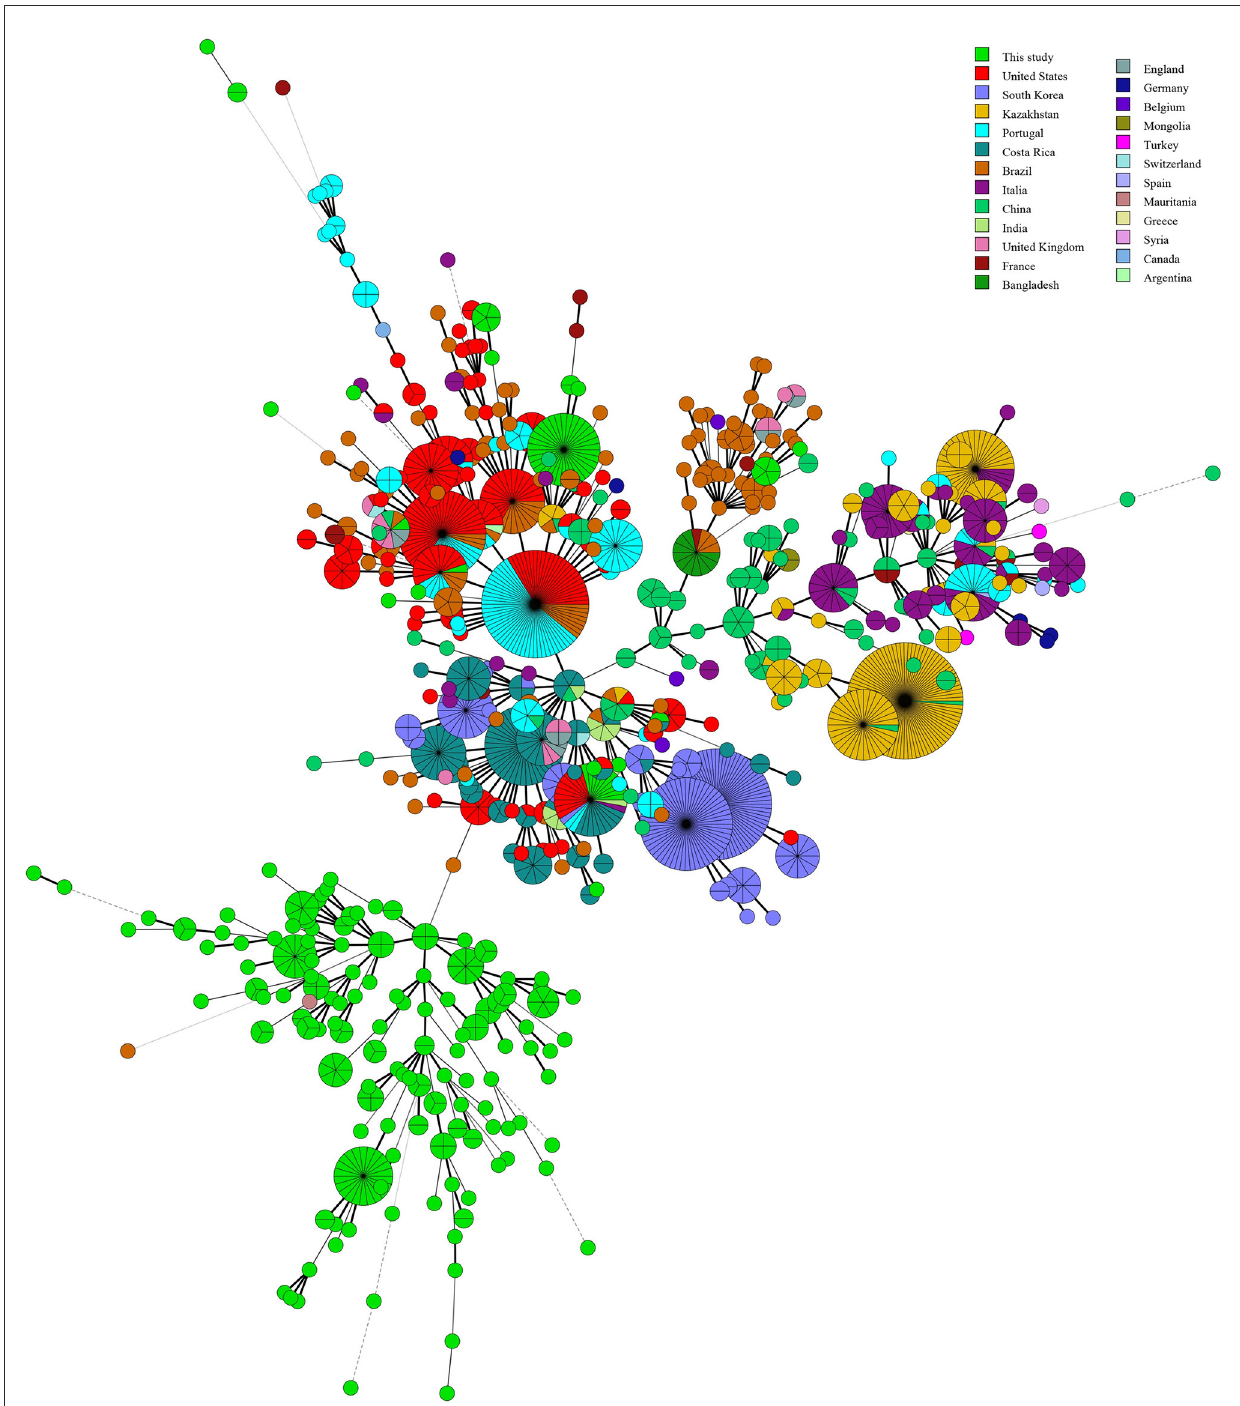
FIGURE6 Molecular relationships between B. abortus strains from West Africa and worldwide strains based on the MLVA-16 data of 1,476 B. abortus strains globally. Color coding according to countries. Circle size indicates the number of strains.